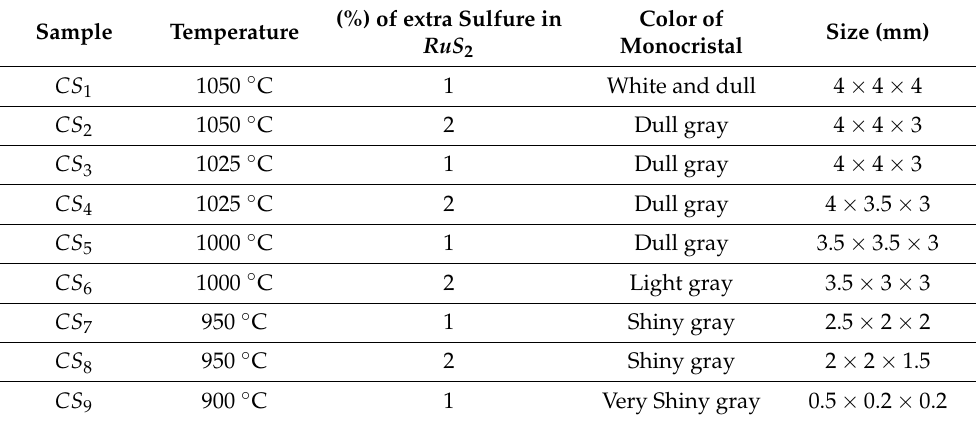
Table 1. The change of the color of grain crystal. This change is associated with a percentage of con- centration of sulfur and the temperature. Additionally, the color of crystals related to the dimension of the grain. However, we succeeded in obtaining RuS 2 by the chemical vapor transport technique.